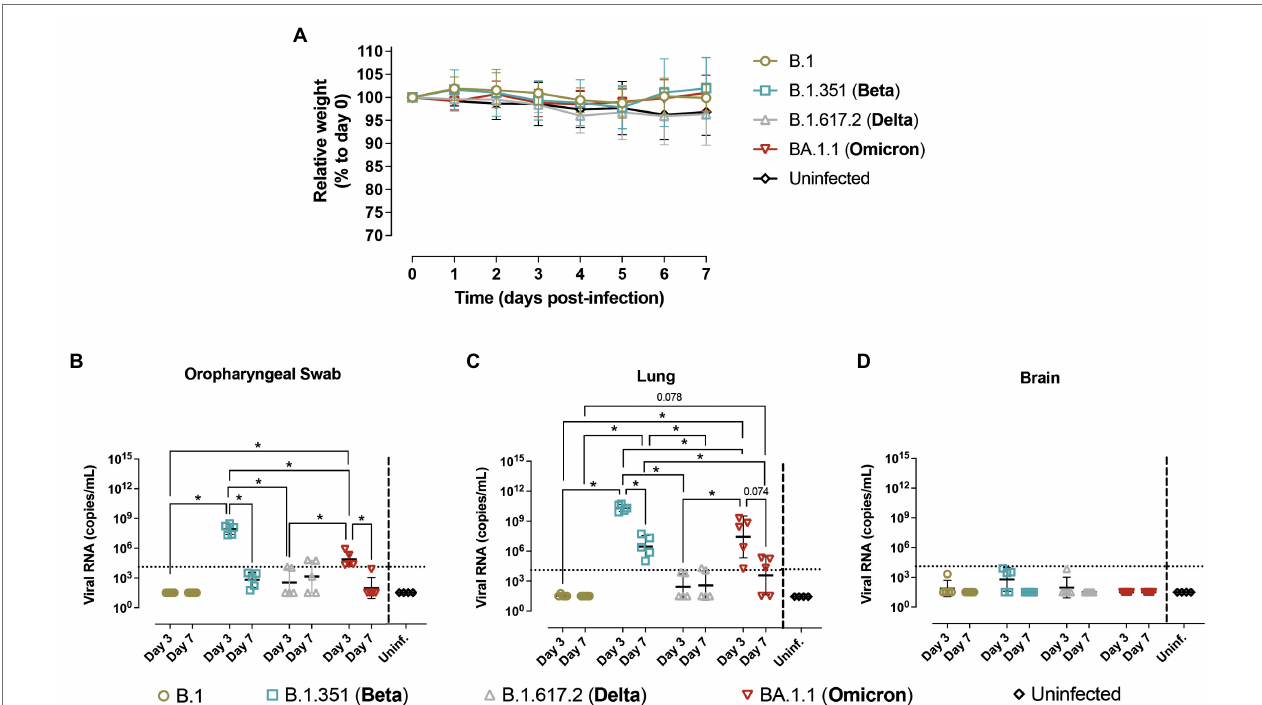
FIGURE 3 | Progression of SARS-CoV-2 infection in hACE2- mice. Wildtype (WT) mice were inoculated with SARS-CoV-2 variants: B.1 (gold, n = 10), B.1.351/Beta (blue, n = 10), B.1.617.2/Delta (grey, n = 10) and BA.1.1/Omicron (red, n = 10) or uninfected (black, n = 4). Animals were euthanized at 3 dpi ( n = 5) and 7 dpi ( n = 5). (A) Relative body weight follow-up of WT mice referred to 0 dpi. Solid lines show the mean ± SD. b-d) SARS-CoV-2 viral RNA load (copies/mL) on different tissues: (B) oropharyngeal swab; (C) lung; (D) brain. Dashed line represents the limit of quantification. For statistical analysis, all data below the limit of detection (2.04) were censored. Statistically significant differences were identified using a Petro-Prentice generalized Wilcoxon test with correction for multiple comparisons (* p <